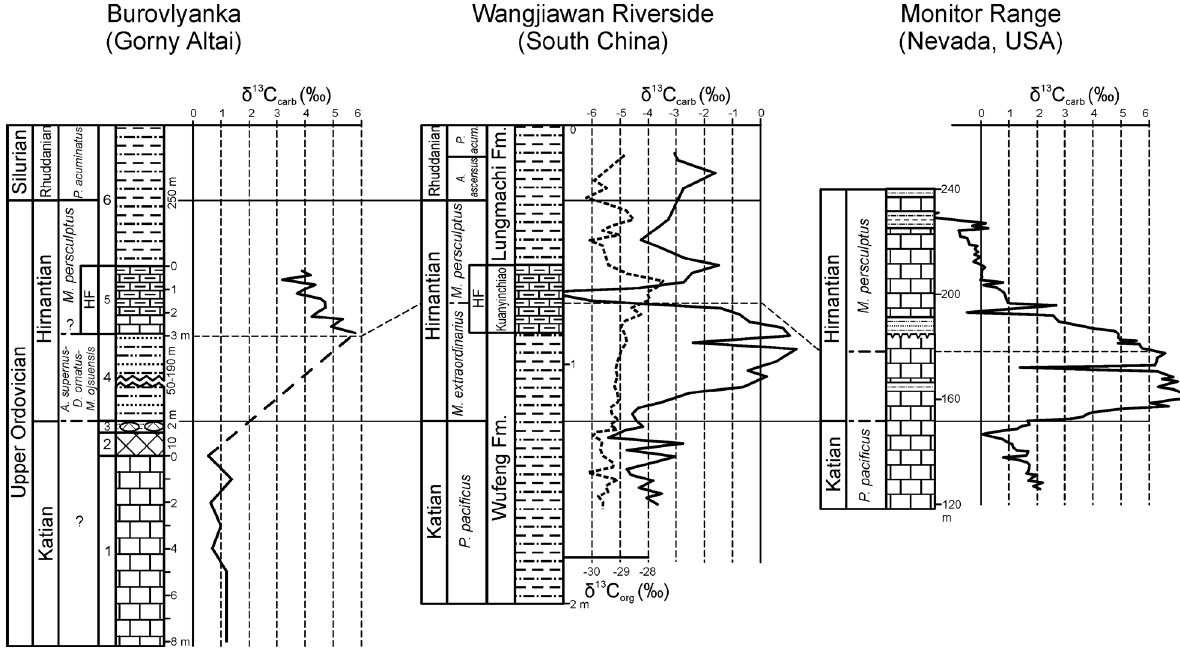
Fig. 4. Comparison of the δ 13 C curves in the Burovlyanka section, the Wangjiawan Riverside section (Gorjan et al. 2012; δ 13 C org curve shown by a dashed line) and the Monitor Range section (LaPorte et al. 2009). The Dalmanitina Member (Bed 5) in the Burovlyanka section could be correlated with the lowermost part of the M. persculptus graptolite Biozone, situated on the upper falling limb of the HICE. HF, carbonate beds with the Hirnantia fauna ( sensu lato ); for lithology see Fig.